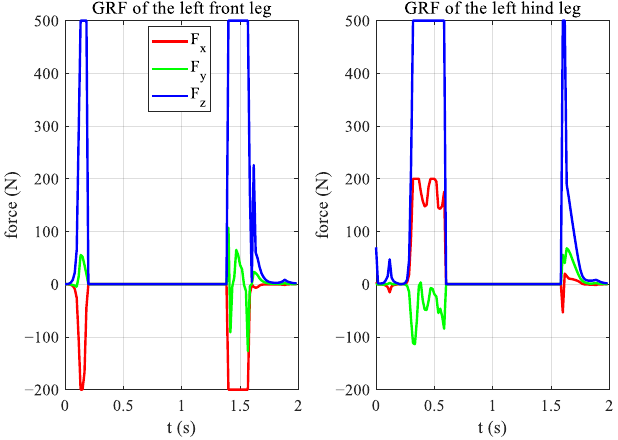
Figure 12. GRF of the forward jumping of the quadruped robot, BQR3.